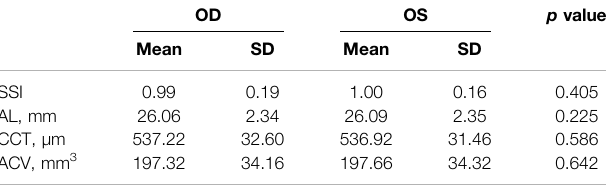
TABLE 2 | Paired t -test comparison of left eye and right eye.